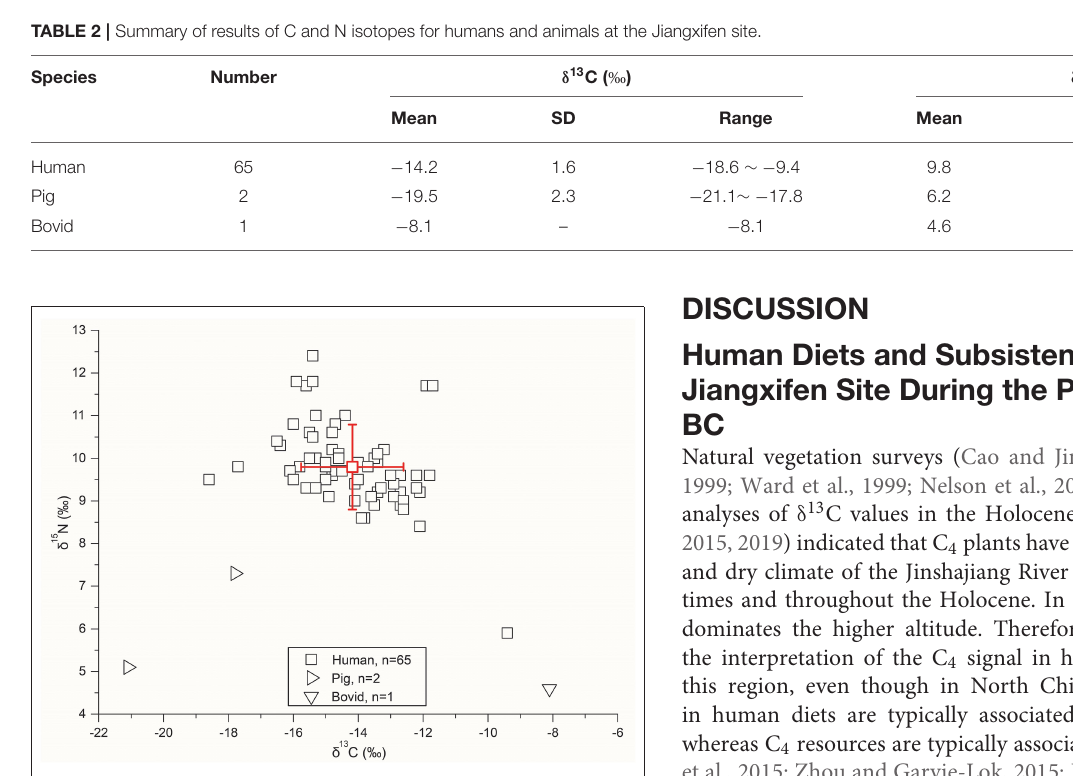
a yield < 1% and with C:N ratios between 2.9 and